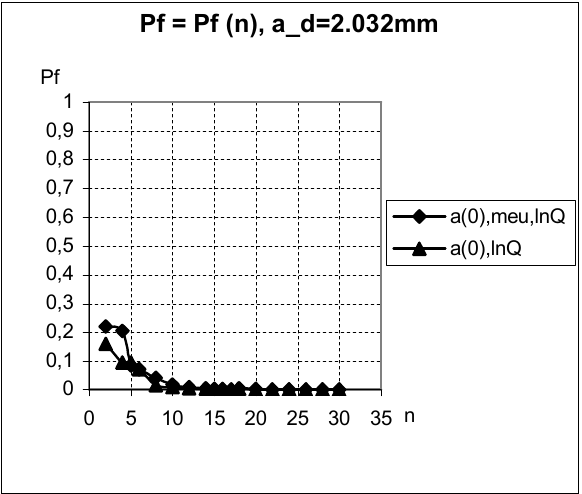
Fig 10. Failure probability in both the cases when m ≠ 2 and m = 2 for the corroded specimens with specified life = 400000 cycles